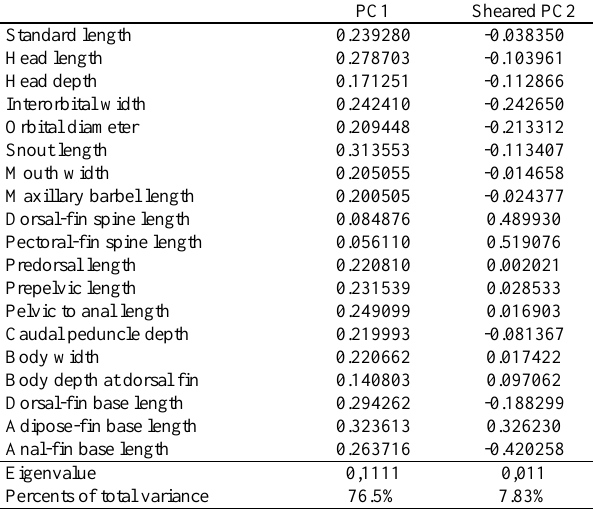
Table 2. Morphometric data loadings, eigenvalues and percentages relating to the first (PC1) and second (sheared PC2) eigenvectors of Principal Components obtained from the analysis of combined samples of Microglanis maculatus (n = 4) and M. robustus (n= 9).